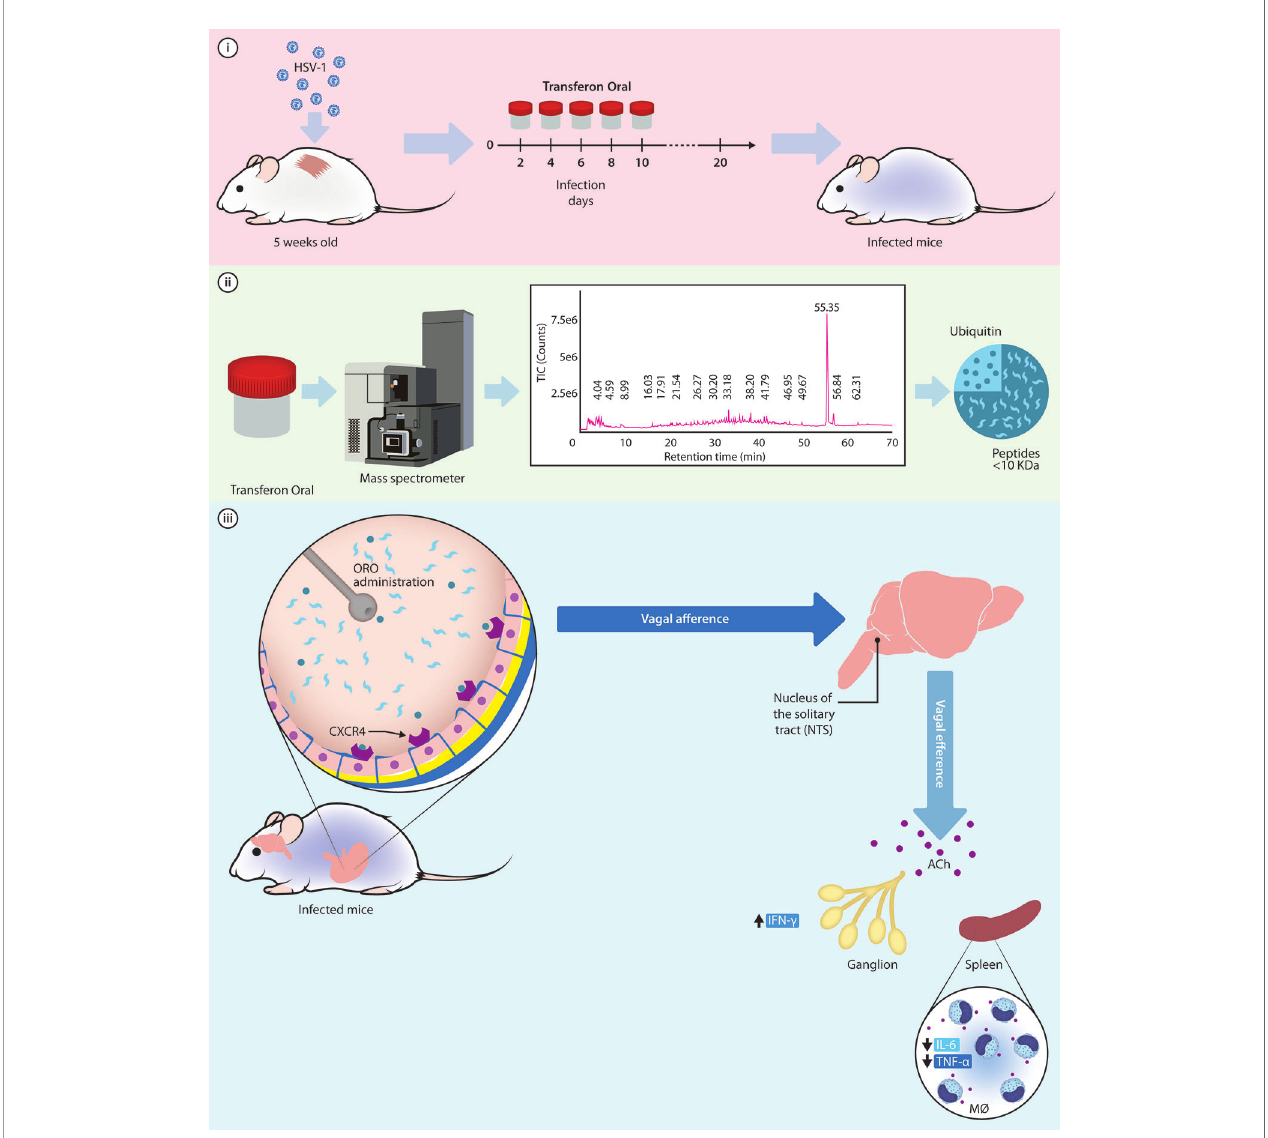
FIGURE 10 | Hypothetical mechanism of action of monomeric Ub to exert its protective function in the murine model of HSV-1 infection. i) Murine model of cutaneous HSV-1 infection can be used to examine the activity of Transferon, where mice receive fi ve doses of the treatment after infection; ii) Through a mass spectrometry analysis, the monomeric Ub and its variant Ub(-GG) were identi fi ed as the most abundant peptide component of Transferon, with a total Ub concentration of 1.003 m g/dose. iii) Once Ub, along with the rest of the peptides of Transferon, is ORO administered in the mice, it could activate the CXCR4 receptor on intragastric vagal nerve endings inducing an increase in ACh release at secondary lymphoid organs and spleen. Then, ACh attenuates the synthesis of TNF- a and IL-6, decreasing the in fl ammatory response in HSV-1infected mice infected and increasing the percentage of survival. HSV, Herpes simplex virus; ORO, oropharyngeal; ACh, acetylcholine; IL, interleukin; IFN, interferon; MØ,